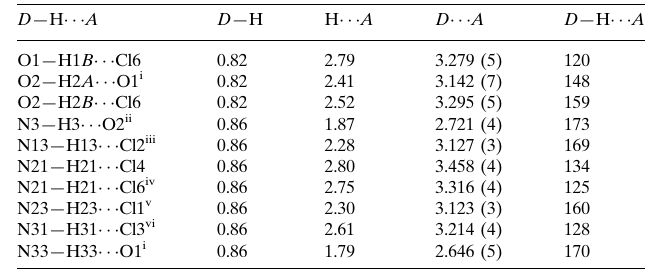
Hydrogen-bond geometry (A˚ , (cid:2)